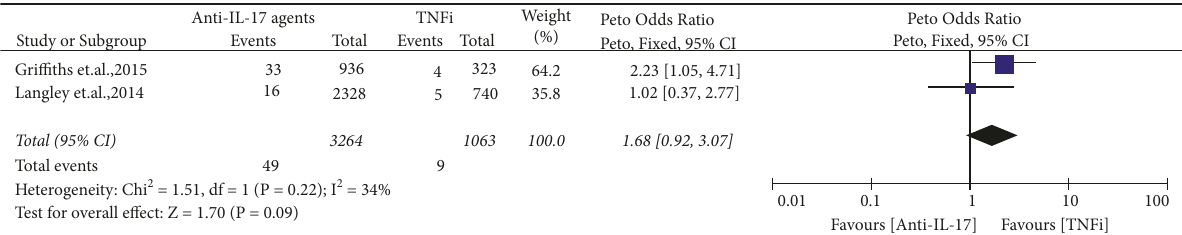
Figure 4: Forest plot of pooled data regarding Candida infections between anti-interleukin (IL)-17 agents and tumor necrosis factor inhibitors (TNFi). CI, confidence